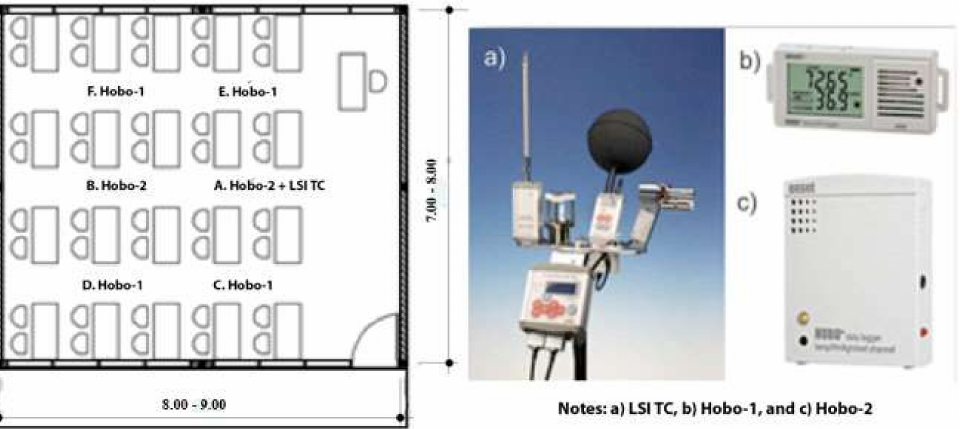
Figure 1. The arrangement of instruments in the typical classrooms ( left ) and the instruments ( right ): ( a ) LSI-Lastem; ( b ) Hobo-1, Hobo temp/Relative Humidity (RH); and ( c ) Hobo-2, Hobo temp/RH/Light/External logger (airflow